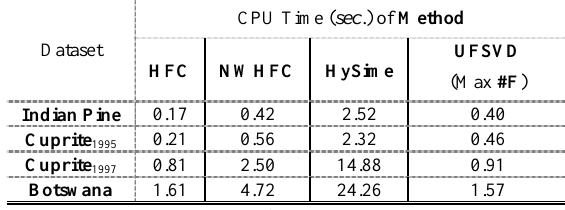
Table 4. Running times of HFC, NWHFC, HySime and UFSVD for the hyperspectral